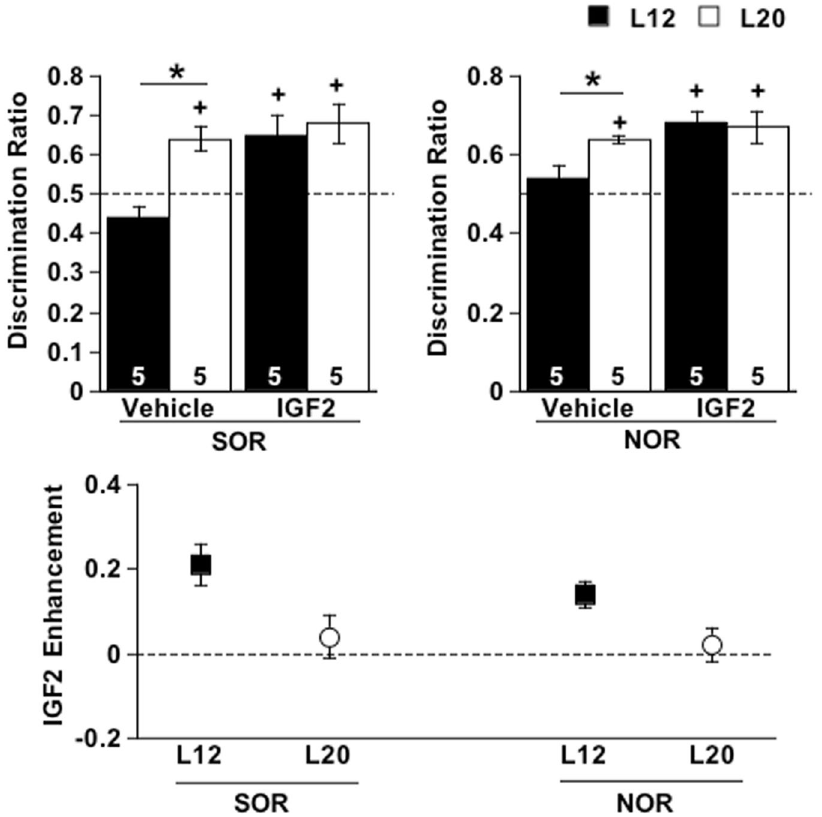
Figure 7. Long days occlude the memory-enhancing effect of IGF2. IGF2 improved SOR and NOR memory in L12 mice, but not L20 mice (Full Factorial ANOVA Photoperiod: F(1,1) = 2.18, p > 0.1, IGF2: F(1,1) = 7.78, p < 0.05, Photoperiod * IGF2: F(1,1) = 4.25, p < 0.05). * L12 versus L20, LS Means Contrasts, p < 0.05. + Differs from 0.5, one-sample Student’s t test, p <